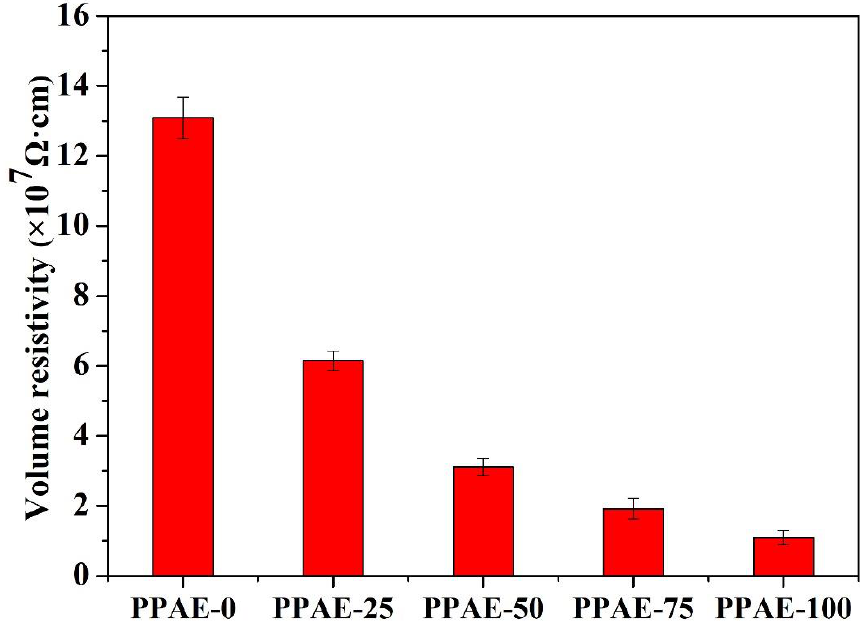
Figure 6. The volume resistivity values of PPAEs with di ff erent content of PZT ceramics.